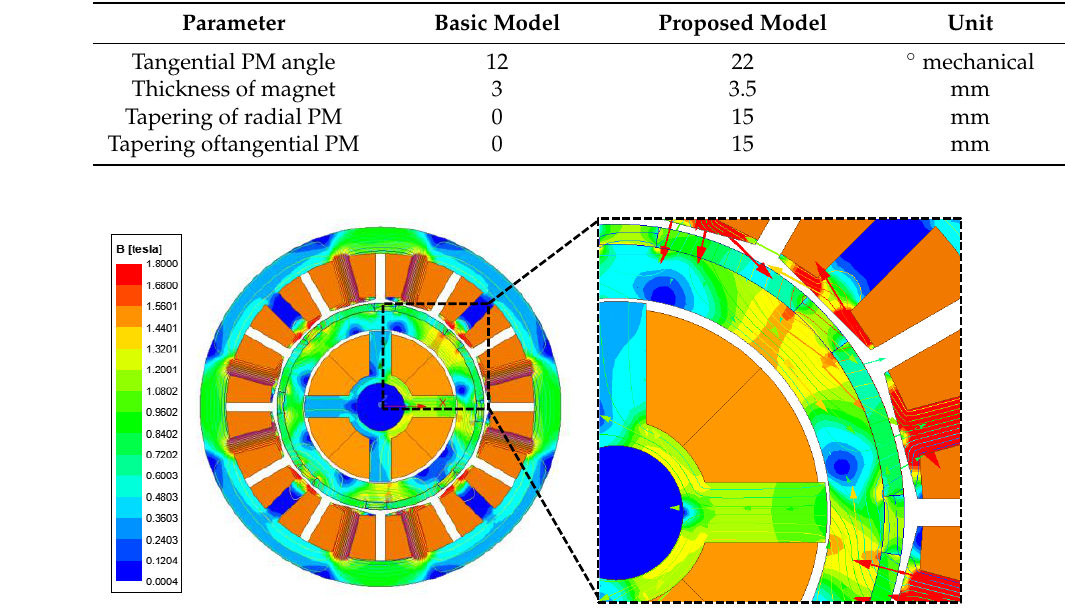
Figure 25. Rotor flux density plot of basic model.